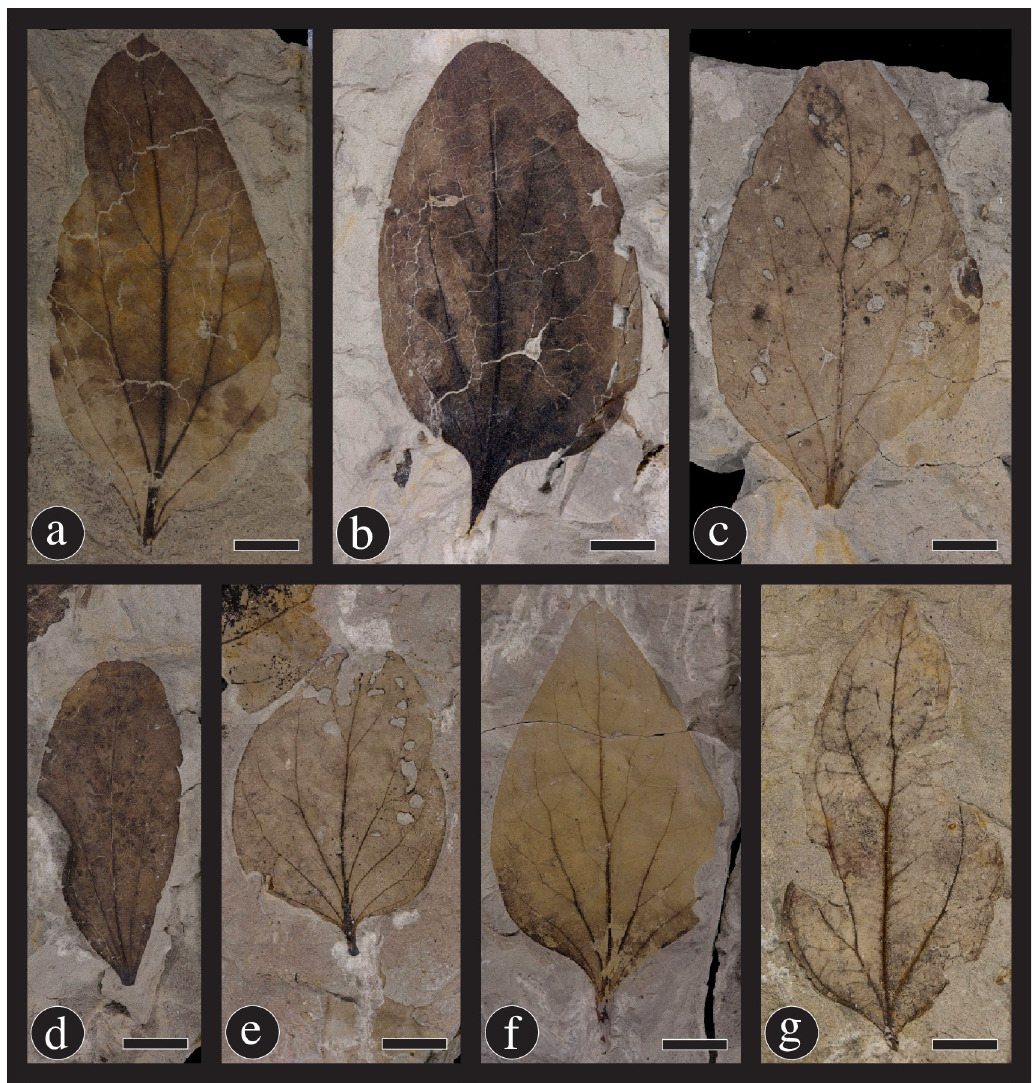
Fig 6. Paratypes of Catula gettyi . These specimens show the range of leaf architecture exhibited by this taxon. (a) DMNH 41570. (b) DMNH 54371. (c) DMNH 54379. (d) DMNH 54370. (e) DMNH 41584. (f) DMNH 41567. (g) DMNH 54380. Scale bars = 1.0